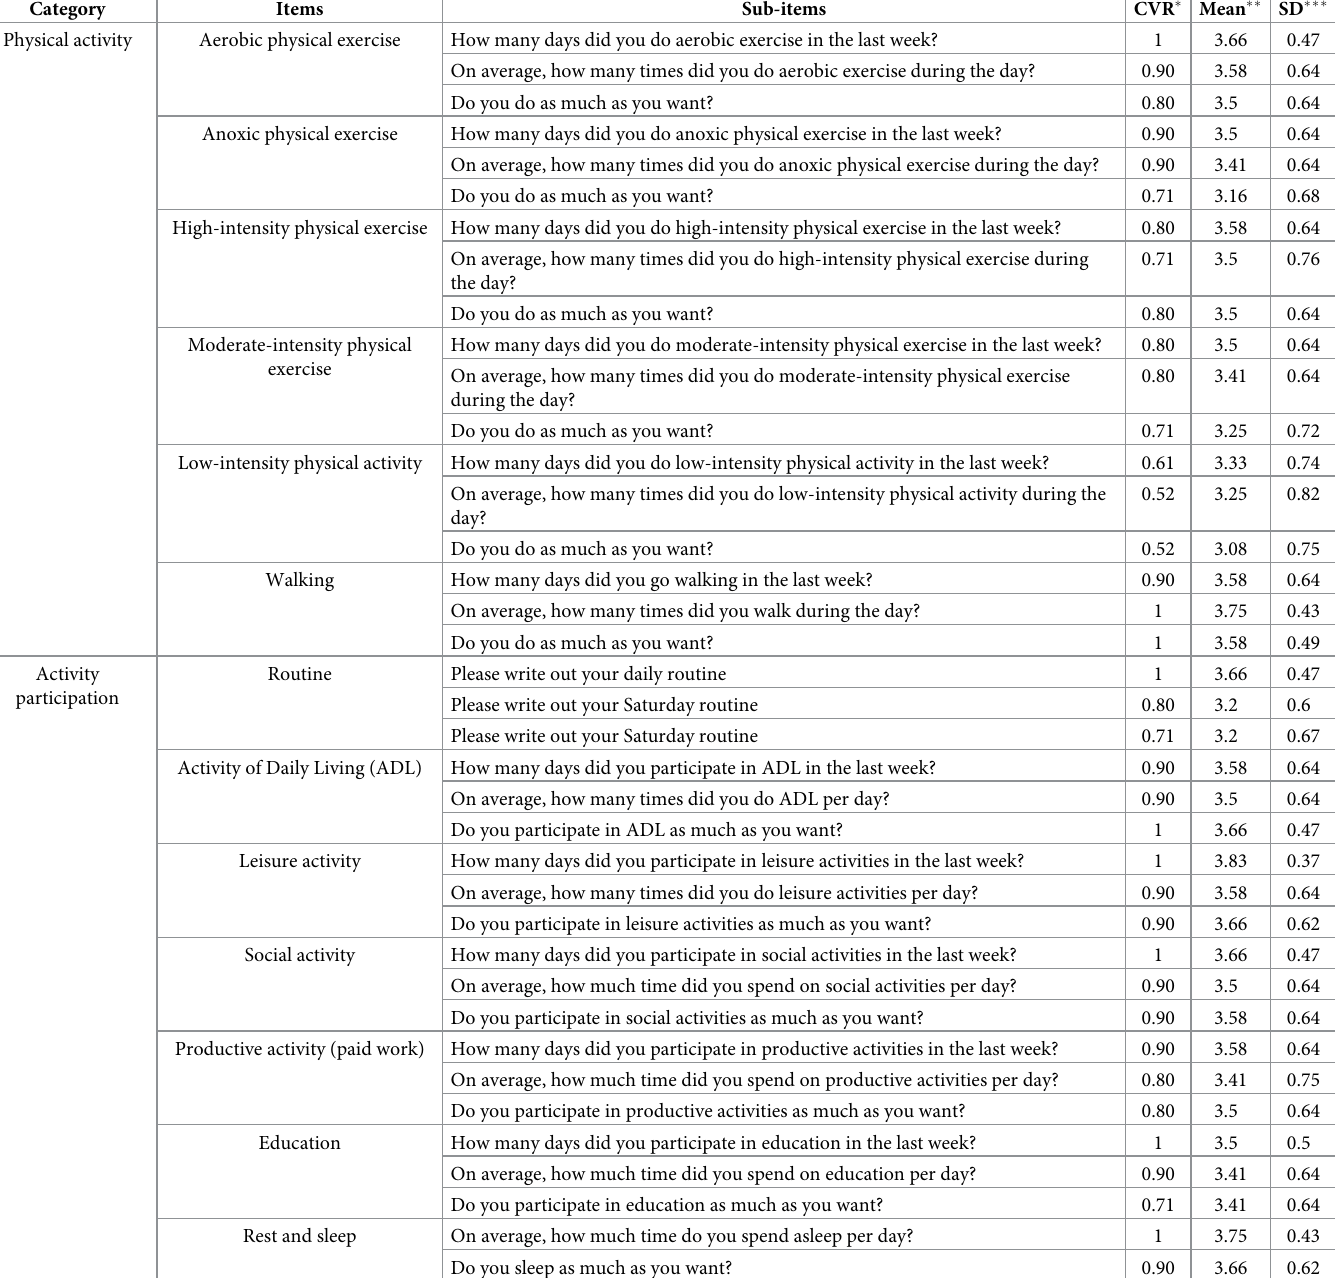
Table 4. Contents of the multifaceted lifestyle in elderly profile in the round 2 survey.